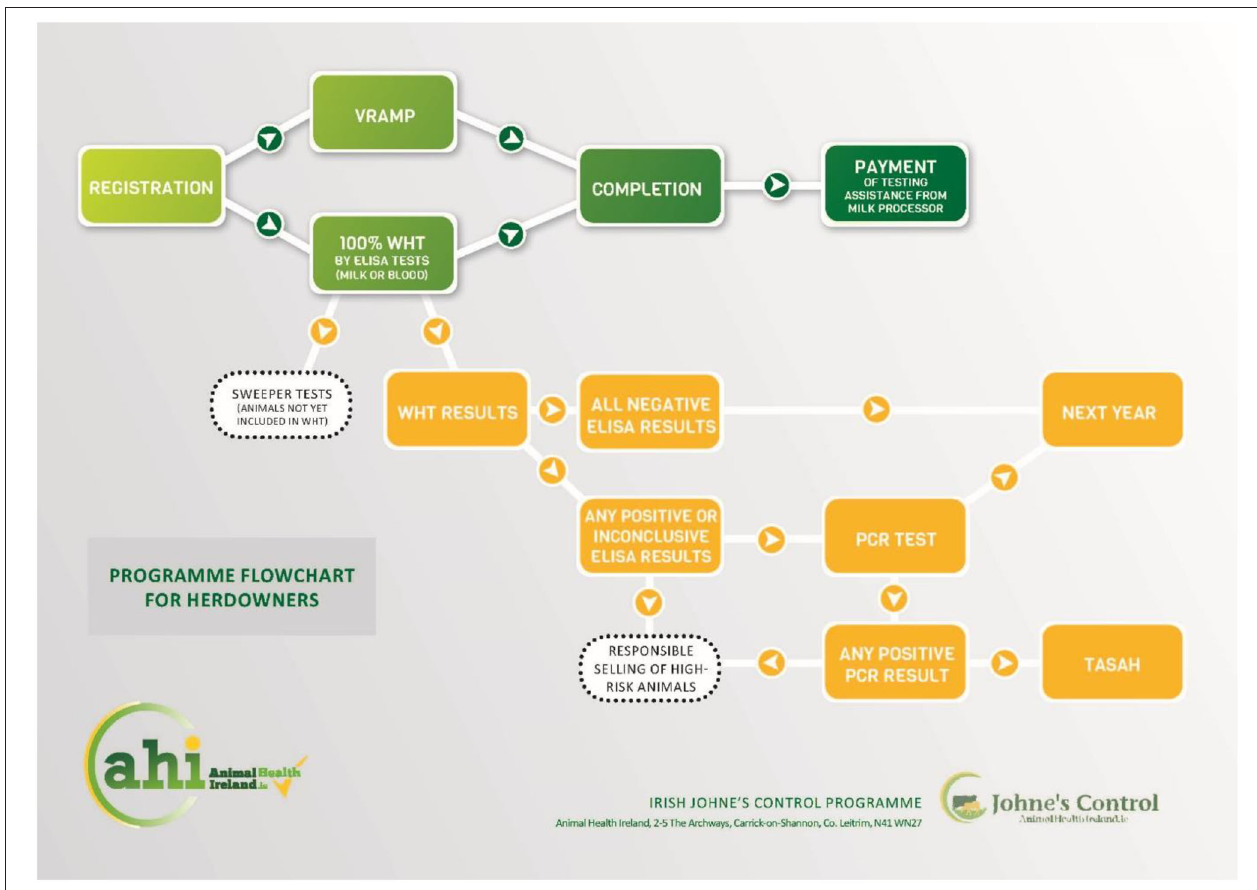
FIGURE 3 | Programme flowchart